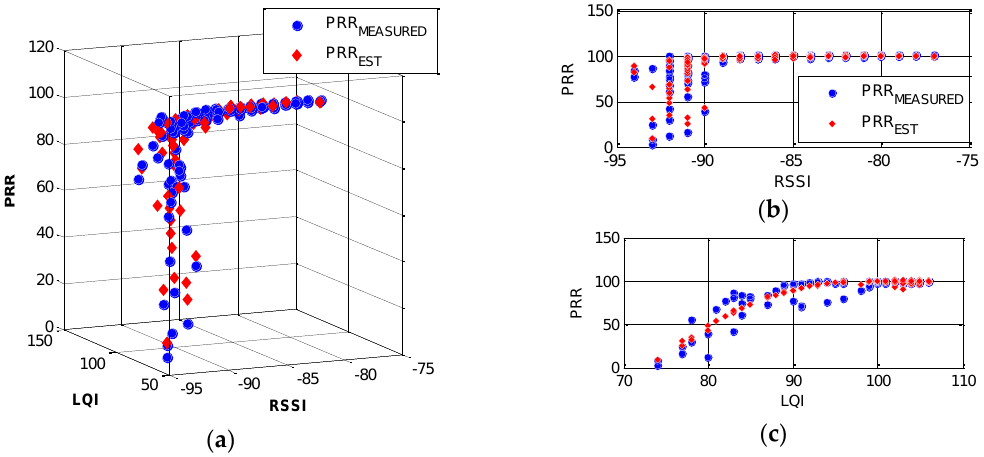
Figure 5. Regression of PRR: ( a ) RSSI-PRR; ( b ) LQI-PRR; and ( c ) RSSI-LQI-PRR relationship.